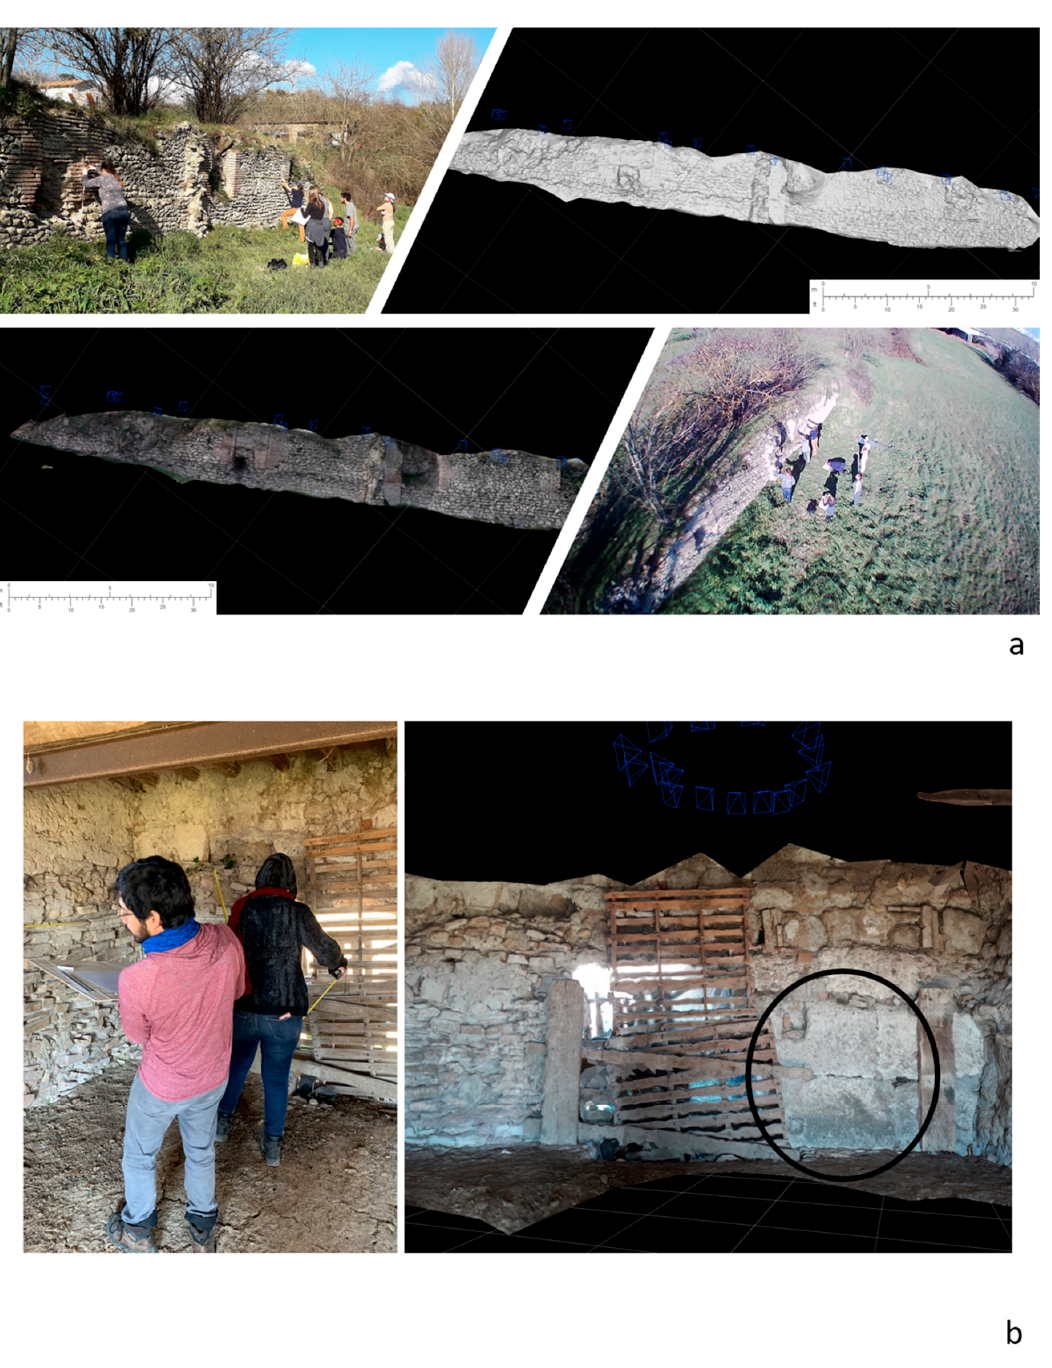
Figure 11. ( a ) The two 3D reconstructions based on the photogrammetry of the ancient wall in San Valentino. ( b ) An internal view of the pigsty with the two in situ masonry blocks on the bottom right.